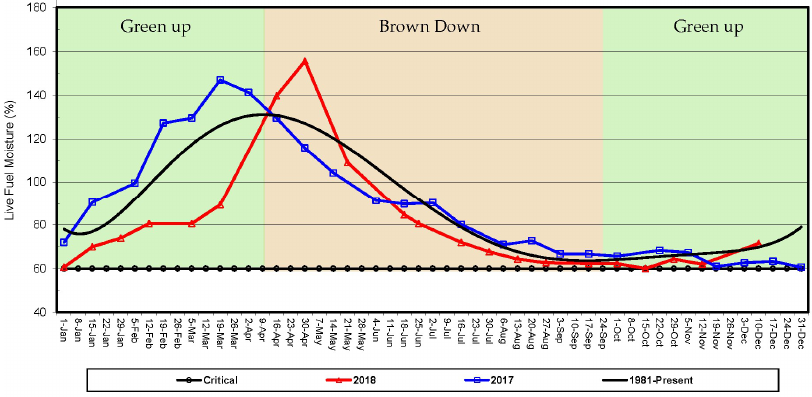
Figure 1. Multi-year average live fuel moisture (LFM) and its dynamics of 2017 (blue) and 2018 (red) in Los Angeles Basin, Southern California (source: County of Los Angeles Fire Prevention Program). The calendar year was divided into green-up (green background) and brown-down (orange background) sections by the direction of the LFM trend across the multi-year average.